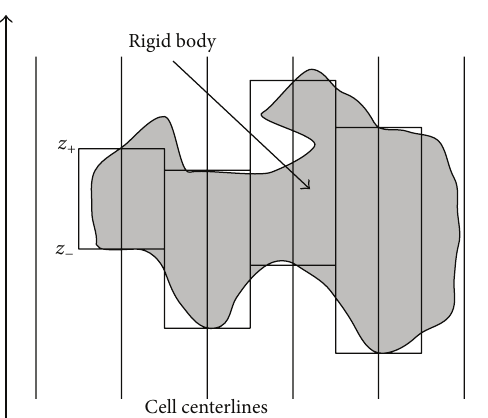
Figure 4: A side view of rasterizing the rigid bodies to the simulation grid. In each cell, the vertical overlap (𝑧 − , 𝑧 + ) of the body and the cell centerline is found. This particular body overlaps 4 cell centers to varying vertical